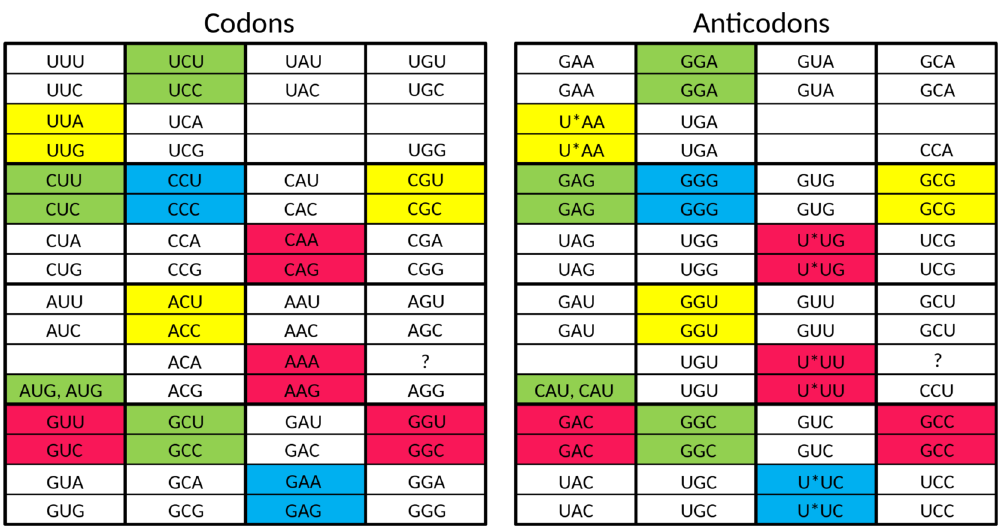
Fig 4. The proposed 32 tRNA stage in the evolution of the standard genetic code. The asterisks indicate anticodon first position modifications which are necessary to unambiguously read the respective codon box. At this stage there already is a distinction between initiator methionine and elongator methionine. Red, yellow, green, and blue are used to indicate the codons where changes happened compared to the situation in the previous